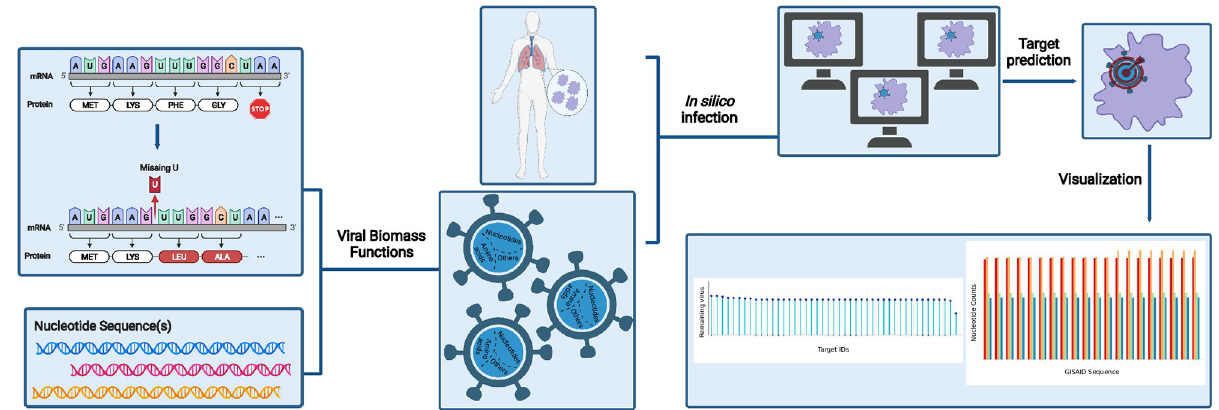
Fig 7. Overview of PREDICATE developed to create viral biomass reactions and predict host-based antiviral targets using host-virus models. First of all, our algorithm, PREDICATE, modifies the amino acids in the protein sequence according to the defined mutations. The mutated protein sequence and the nucleotide sequences are further employed to calculate the stoichiometric coefficients for the virus biomass functions. Reaction knock-outs and the host-derived enforcement are applied to reveal enzymatic reactions that suppress the viral replication. The final step generates various plots, providing insights into the dataset and a better understanding of the results. This pipeline can be applied to either one or more nucleotide sequences and all existing RNA viruses. This makes it particularly advantageous and time-saving when studying multiple variants of a single virus. The number of genomic input sequences equals the number of the calculated VBOF. The Materials and Methods section describes the implemented approaches to predict antiviral targets. Figure created with BioRender (BioRender.com).